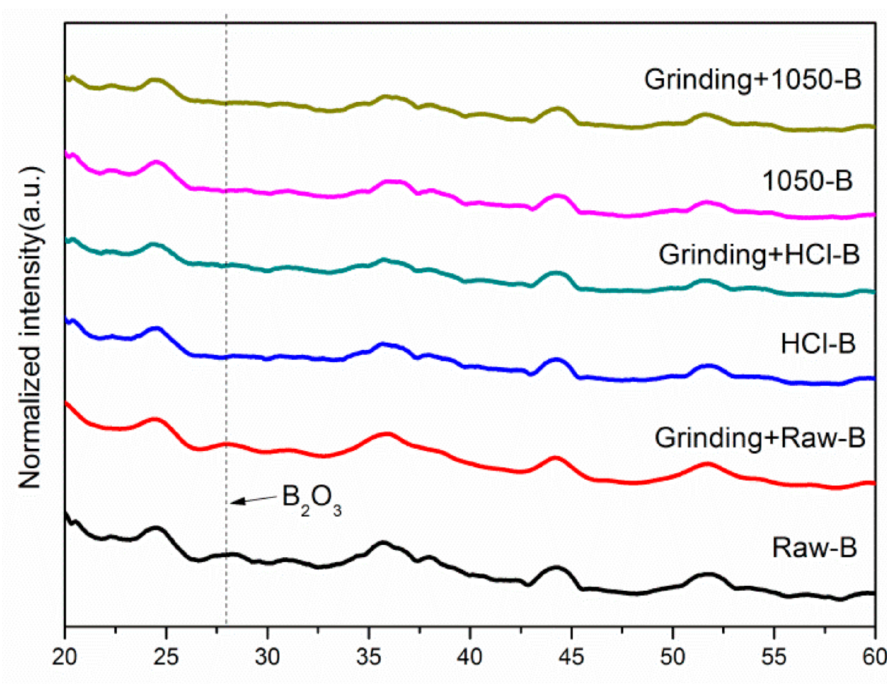
Figure 1. XRD results of B powder after different purifications. Table 1. List of boron powders with different purification methods, relevant oxygen content, and particle